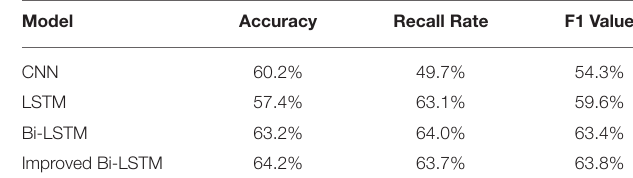
TABLE 2 | Comparative data of different models.